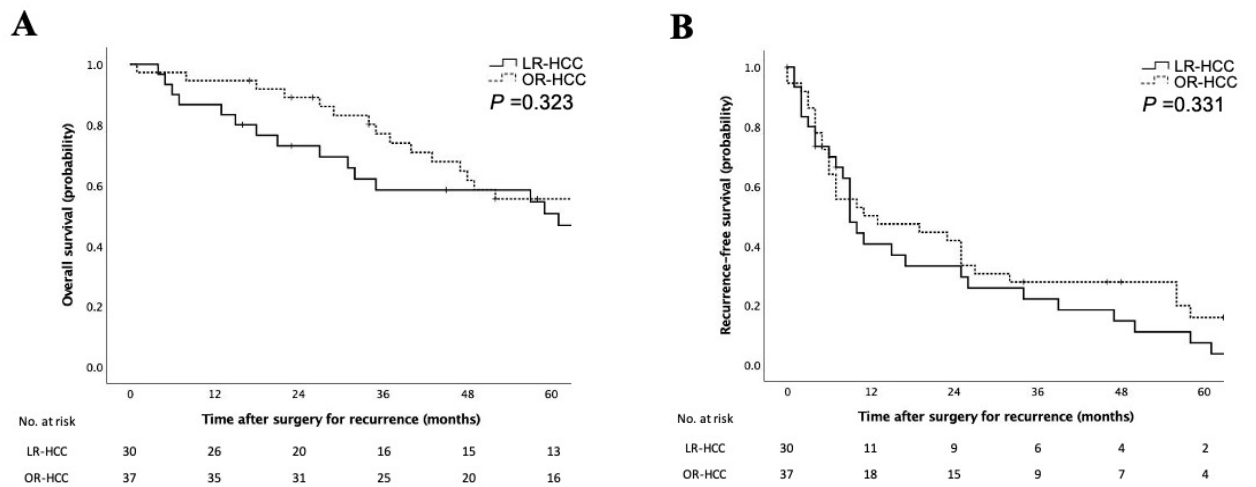
Figure 2. Survival analyses according to recurrence patterns after the locoregional treatment. Kaplan–Meier curves for overall survival rates ( A ) and recurrence-free survival rates ( B ) of patients according to recurrence patterns after the locoregional treatment. Survival rates were comparable between locally recurrent and other types of recurrent hepatocellular carcinoma in the log–rank test. LR-HCC, locally recurrent hepatocellular carcinoma after locoregional therapy; OR-HCC, other types of recurrent hepatocellular carcinoma after locoregional therapy.